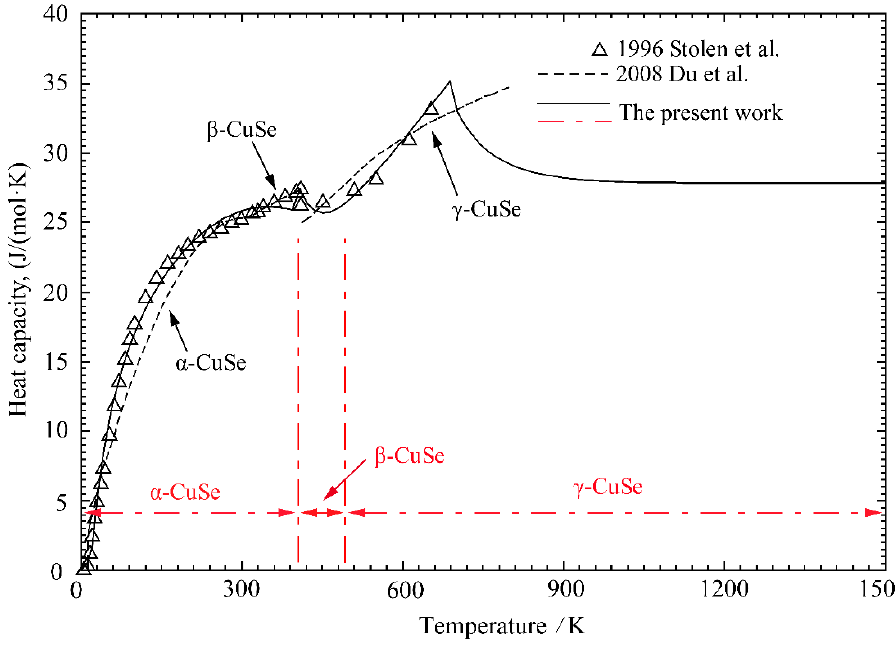
Figure 14. The calculated activities of Cu and Se at 1100 °C in the Cu-Se system compared with the experimental data from refs. [102] and previously optimized results by Du et al. [100]. 4.3. Zn-Se Binary System In the present work, the MQM model was used for liquid phase to optimize the Zn- Se binary system. The calculated phase diagram, compared with the experimental data [108,109,111,113] and optimized data [125], is shown in Figure 15 , and it is in strong agree- ment with those data. Moreover, the melting point of ZnTe was optimized to be 1522 °C